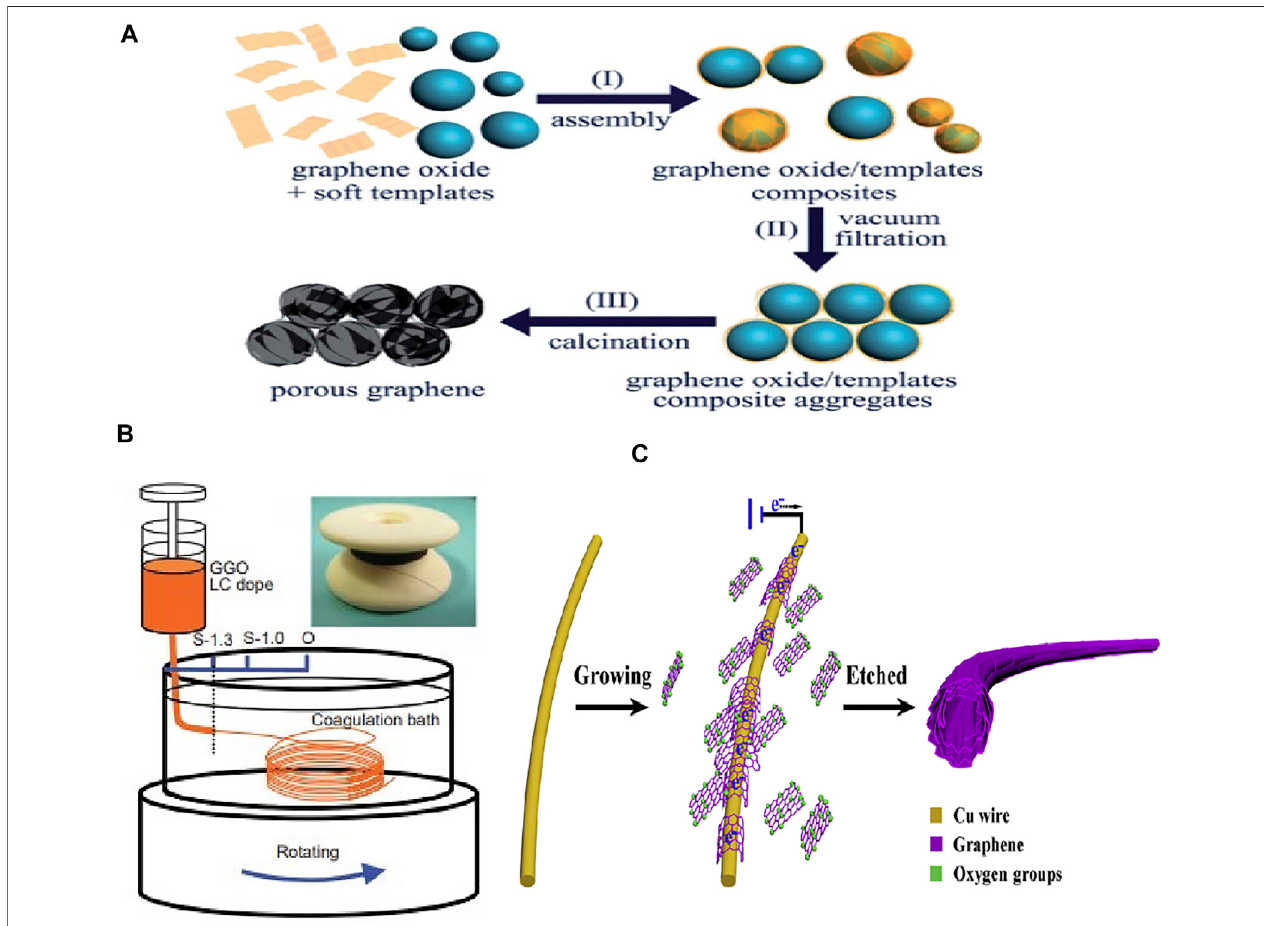
FIGURE2|(A) Schematicillustrationoftheemulsionsoft-templatesynthesisproceduresforpreparingporousgraphenefoams;(Figuresreprintedfromref.45with permission. Copyright 2014; The Royal Society of Chemistry); (B) Schematic apparatus for spinning GGO fi bers; (Figures reprinted from ref. 54 with